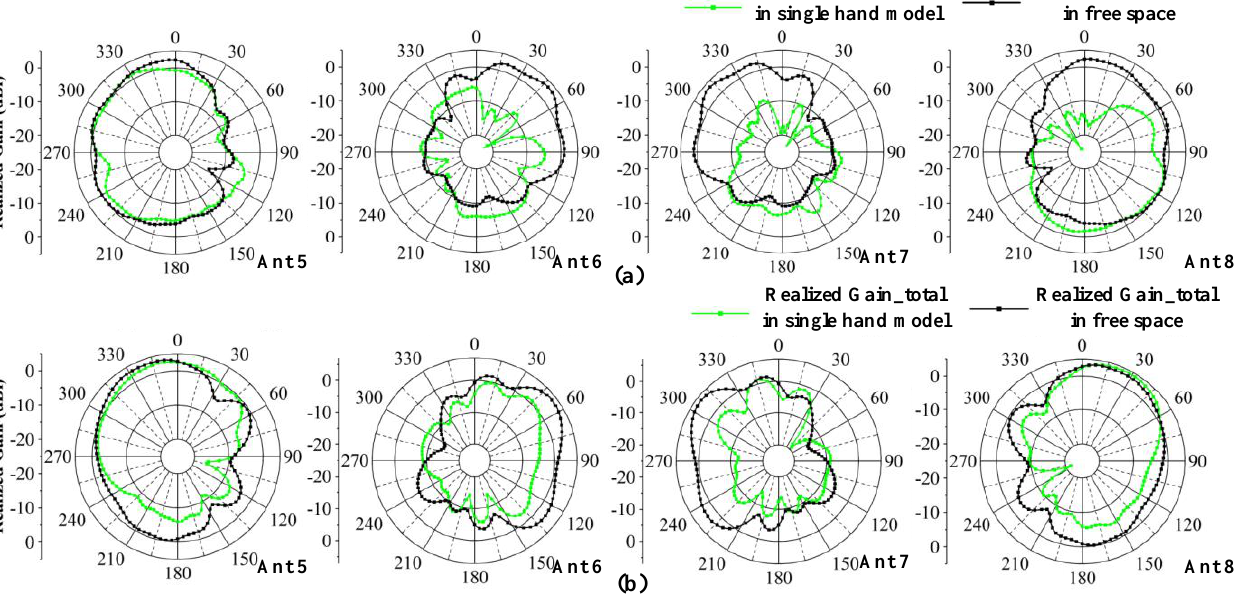
Figure 22. Comparisons of radiation pattern observed from 4.5 GHz. ( a ) 2-D radiation pattern in the 𝑥𝑜𝑦 plane. ( b ) 2-D radiation pattern in in the 𝑦𝑜𝑧 plane. xoy plane. ( b ) 2-D radiation pattern in in the yoz